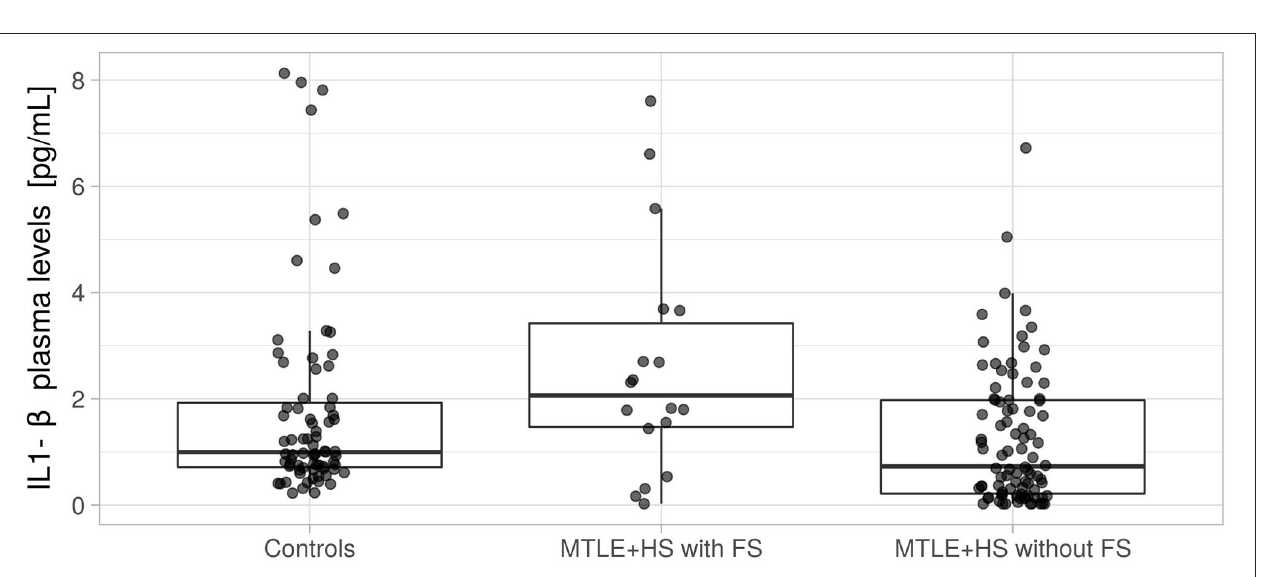
FIGURE 2 | Quantification of interleukin 1 beta (IL-1 β ) protein in plasma from controls, patients with mesial temporal lobe epilepsy with an antecedent of febrile seizure (MTLE + HS with FS), and patients with mesial temporal lobe epilepsy with no antecedent of febrile seizure (MTLE + HS without FS). We used the Wilcoxon rank-sum test to compare patients with MTLE + HS with FS and controls ( p = 0.1639) and compare patients with MTLE + HS without FS and controls ( p =